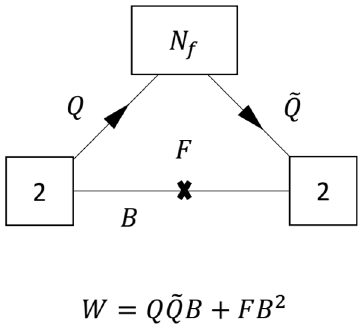
f +1 (cid:18) √ (cid:19) 8 − N f ; 1 , 1 , . . . , 1 . As customary, 4 4 4 4